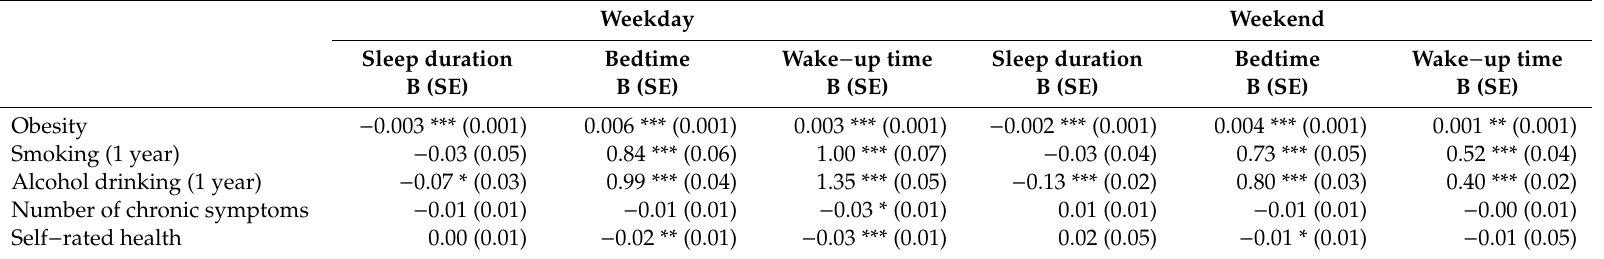
Table 2. Mixed e ff ects regression analyses of health outcomes and health risk behaviors with sleep